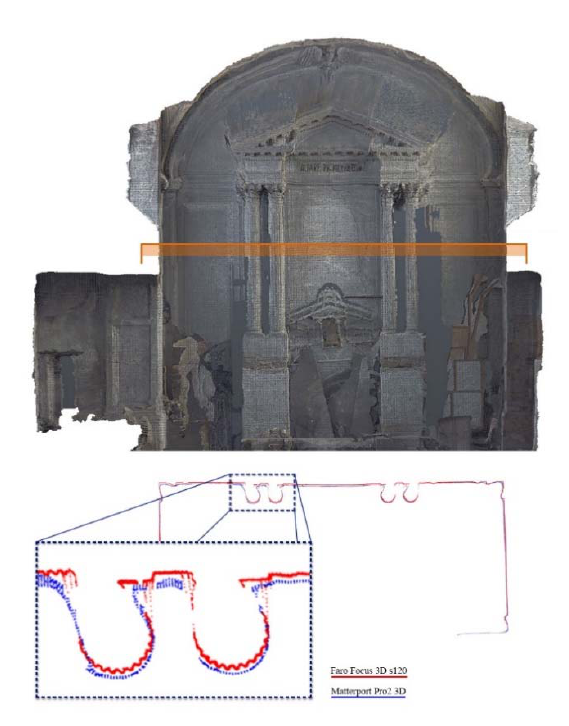
Figure 10: Detail of the coupled columns of the apse altar. Comparisons between laser scanner cloud and Matterport Pro2 3D cloud: plan view and three-dimensional view.